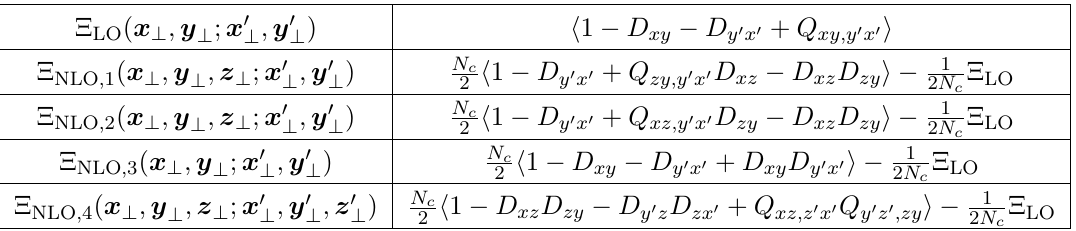
Table 1 . Color correlators contributing to the next-to-leading order